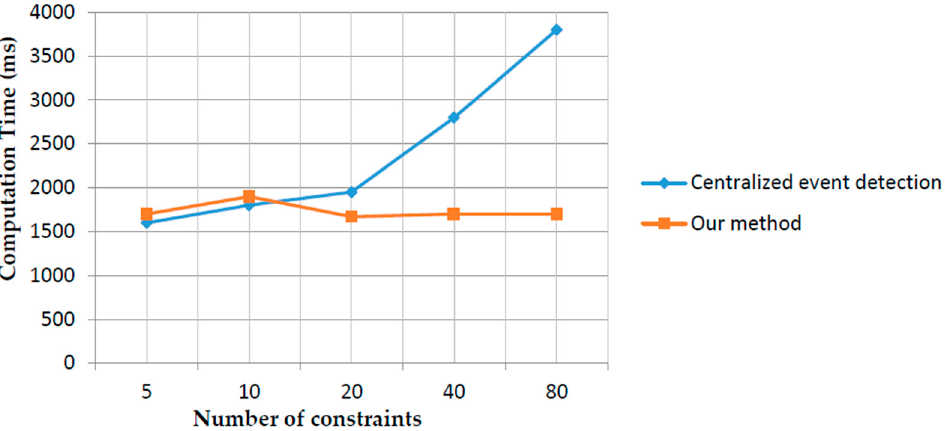
Figure 21. The comparison of the computation time between our distributed event detection and the centralized/distributed event detection in terms of the number of constraints.